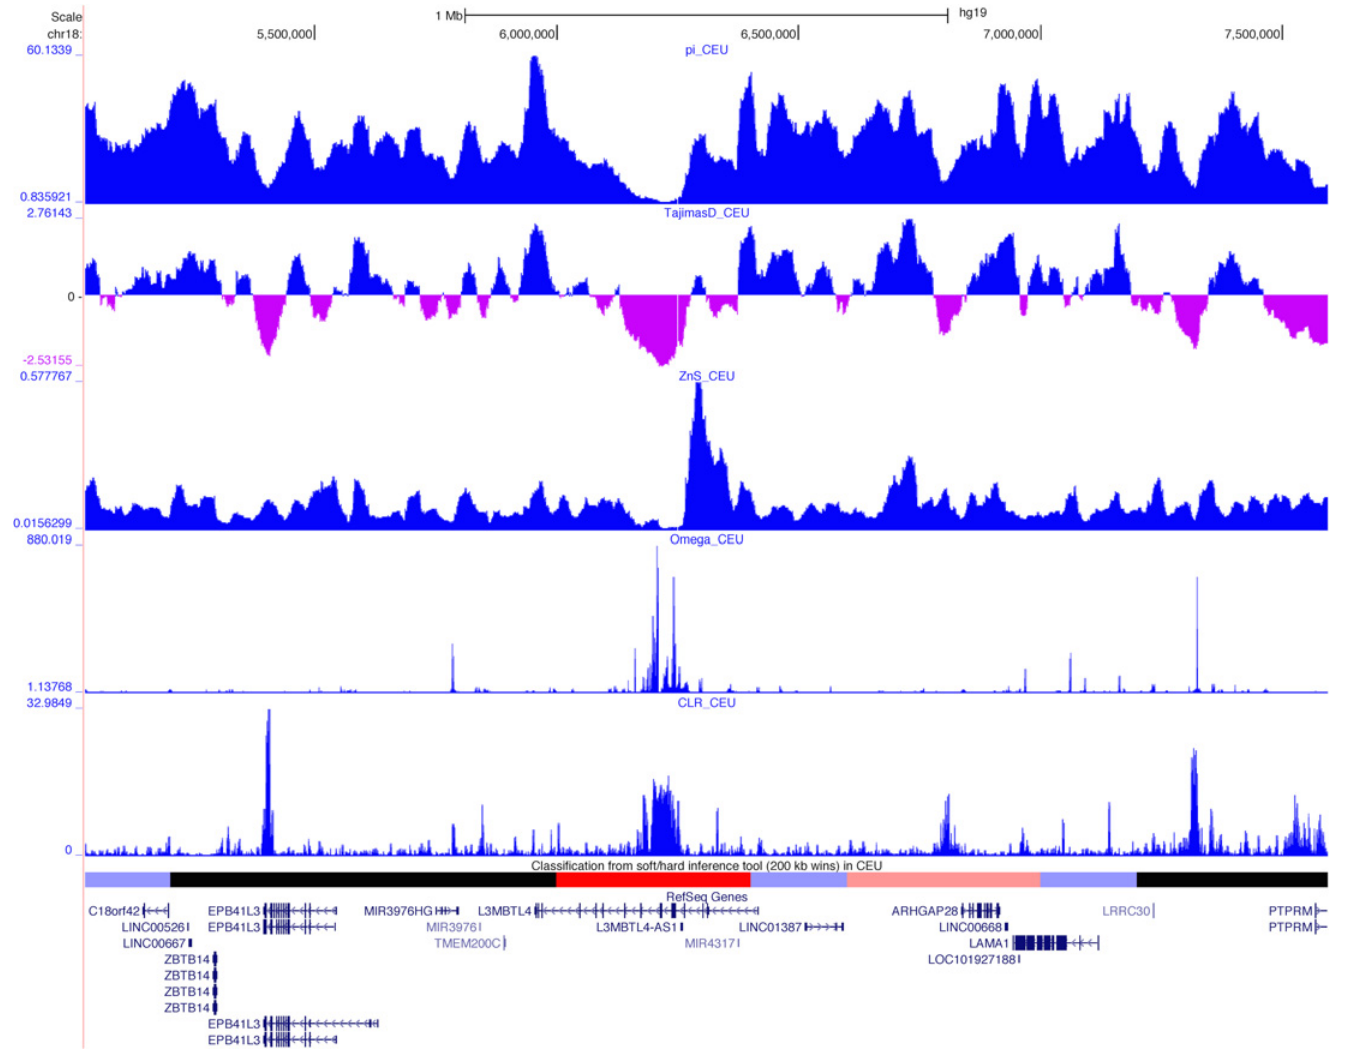
Fig 8. Browser screenshot showing patterns of variation around a putative selective sweep in Europeans within L3MBTL4 on chr18. Values of π , Tajima ’ s D , Kelley ’ s Z nS , and Nielsen et al ’ s composite likelihood ratio, all from Pybus et al. [59], are shown. Beneath these statistics we show the classifications from S/HIC (red: hard sweep; faded red: hard-linked; blue: soft sweep; faded blue: soft-linked; black: neutral). This image was generated using the UCSC Genome Browser (http://genome.ucsc.edu).